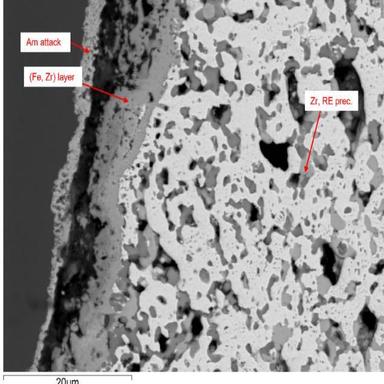
High magnification detail of the fuel cladding chemical interaction (FCCI), region 4 in